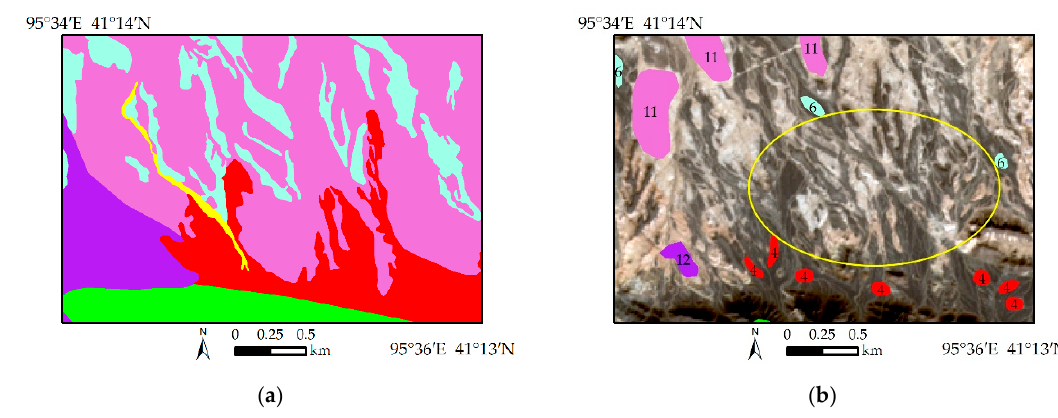
Figure 8. ( a ) Geological map of the eastern part of the study area; ( b ) Sentinel ‐ 2A imagery (R: Band 4; G: Band 3; B: Band 2) and the samples are shown. The area circled in yellow is where the classification results are partially different from the geological map. Refer to Figure 1 and Figure 4 for legend.